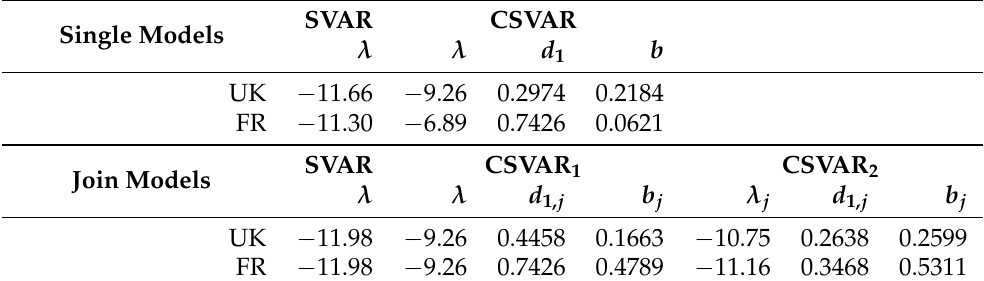
Table A1. Tuning